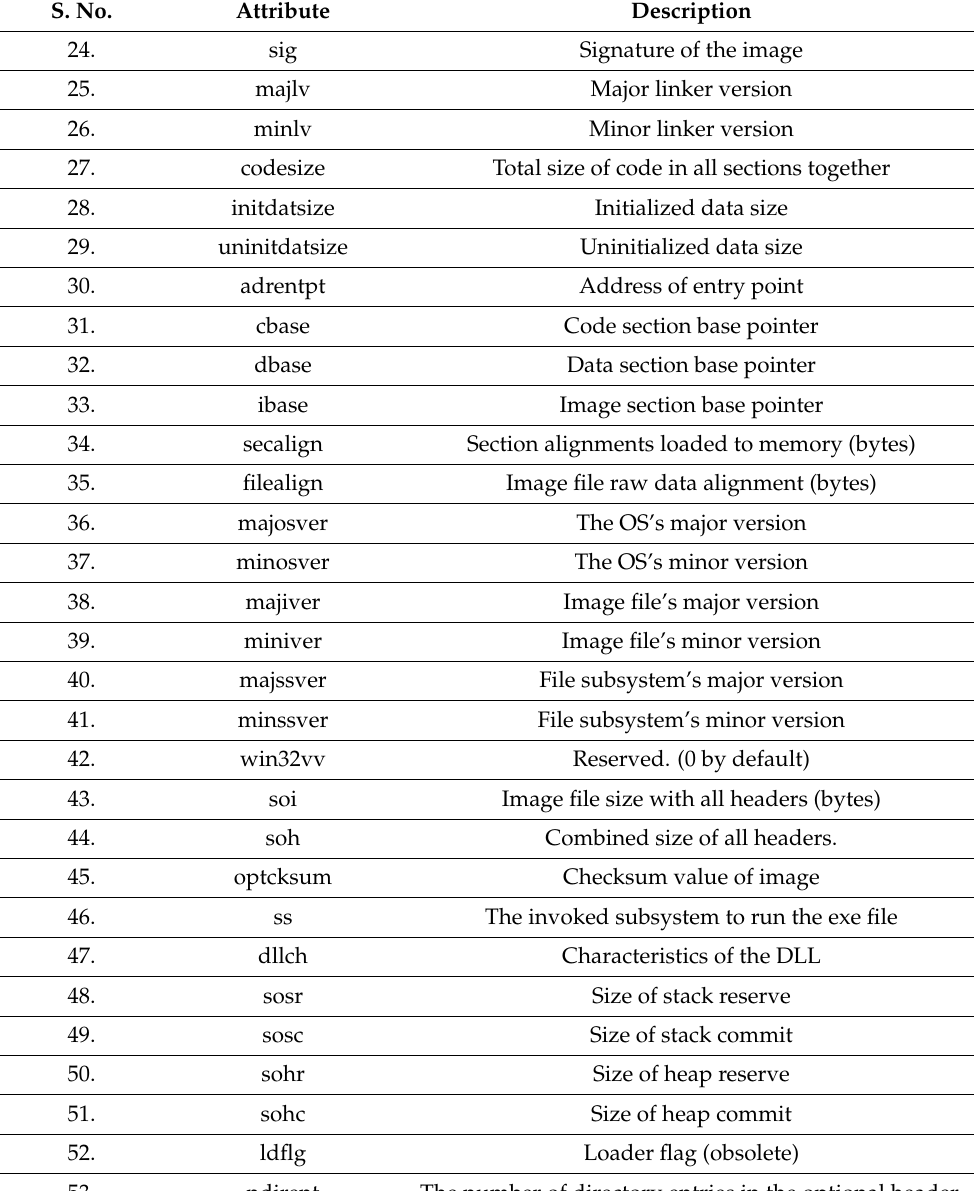
Table 3. Attributes from